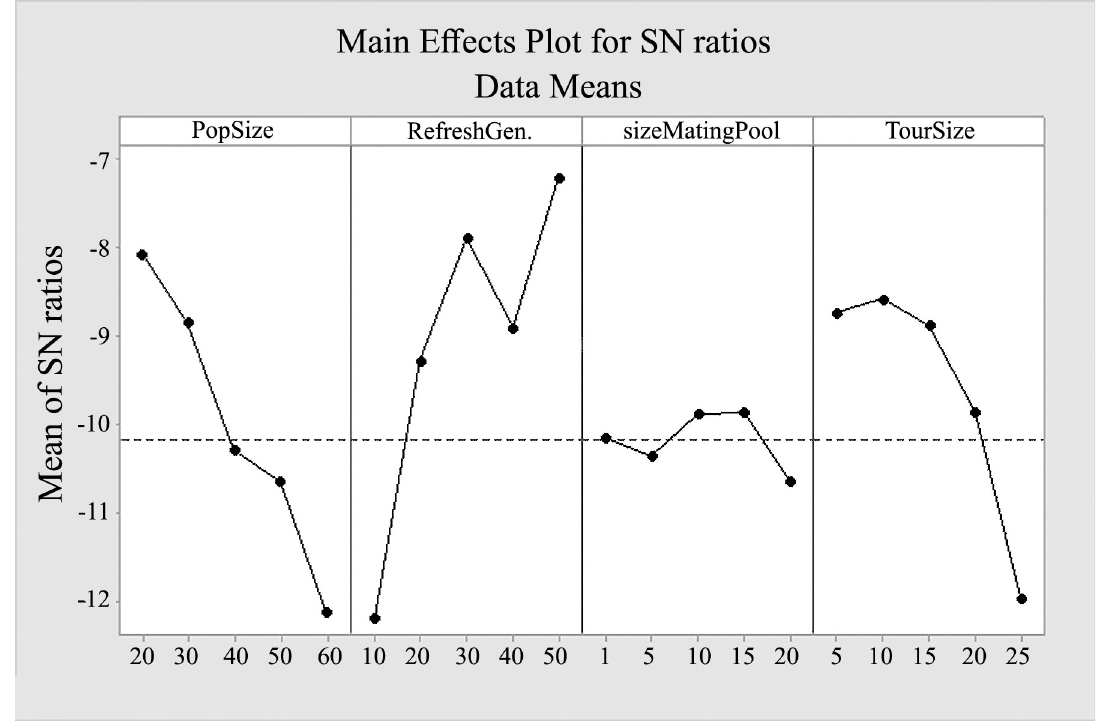
Fig 13. Graphical results of Taguchi method for AMADE